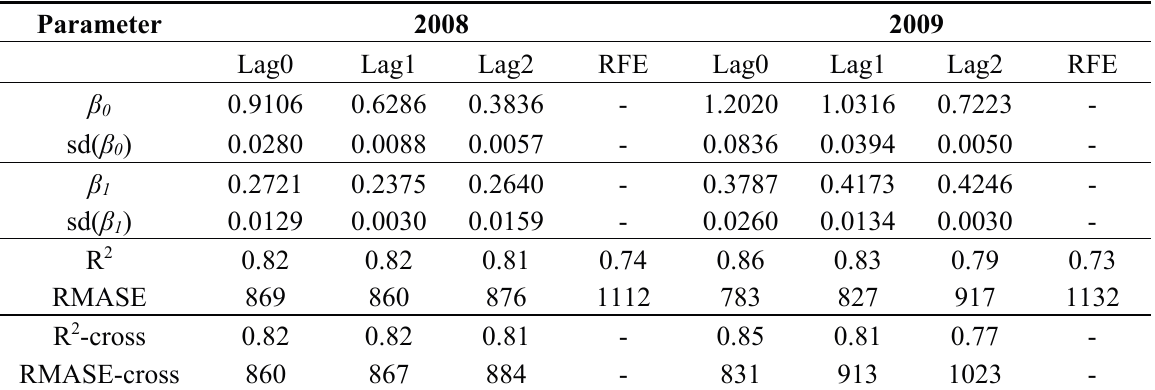
Table 3. Estimation of the number of villages having sown per dekad and department based on green-up onset detection (Lag columns) versus rainfall method (RFE) for 2008 and 2009. Statistics followed by “cross” refer to predictions for one year based on the parameters estimated for the other year.